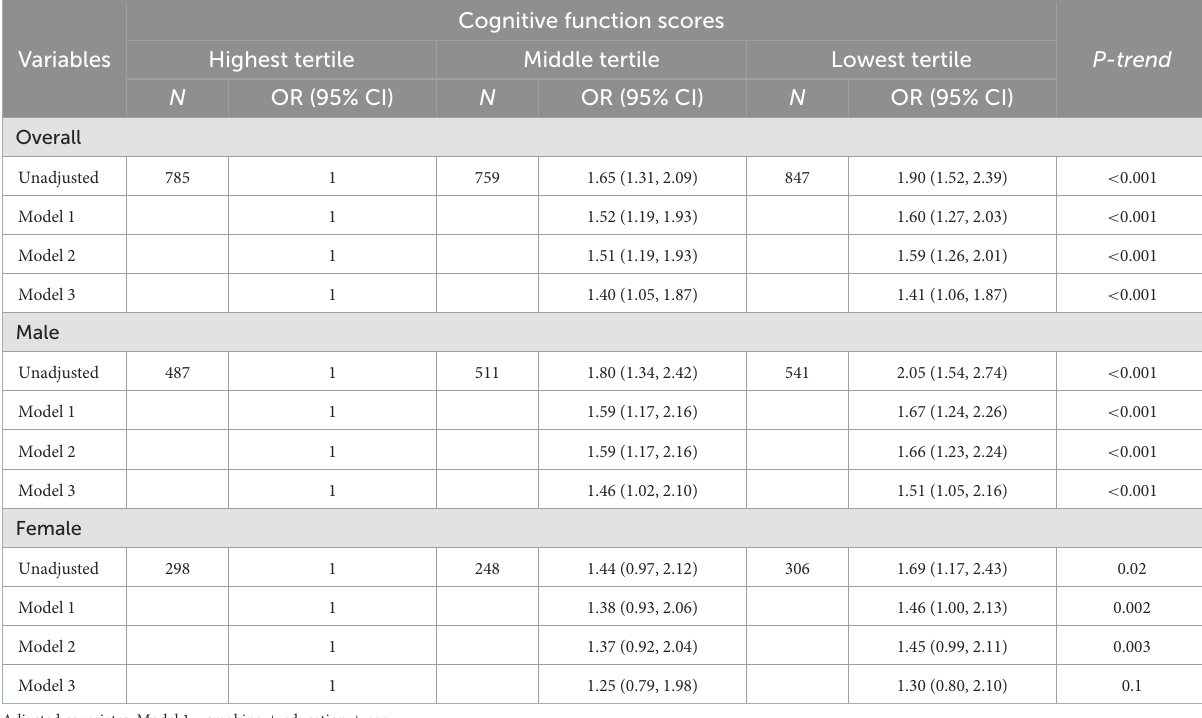
TABLE 4 Association between Sarcopenia and cognitive function.